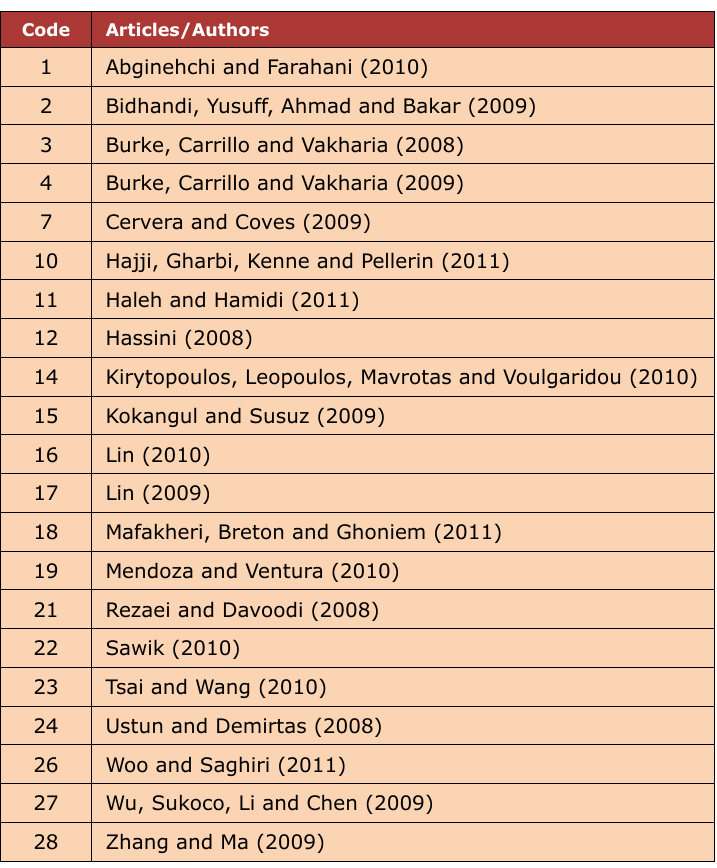
Table 3. Correspondence between codes and